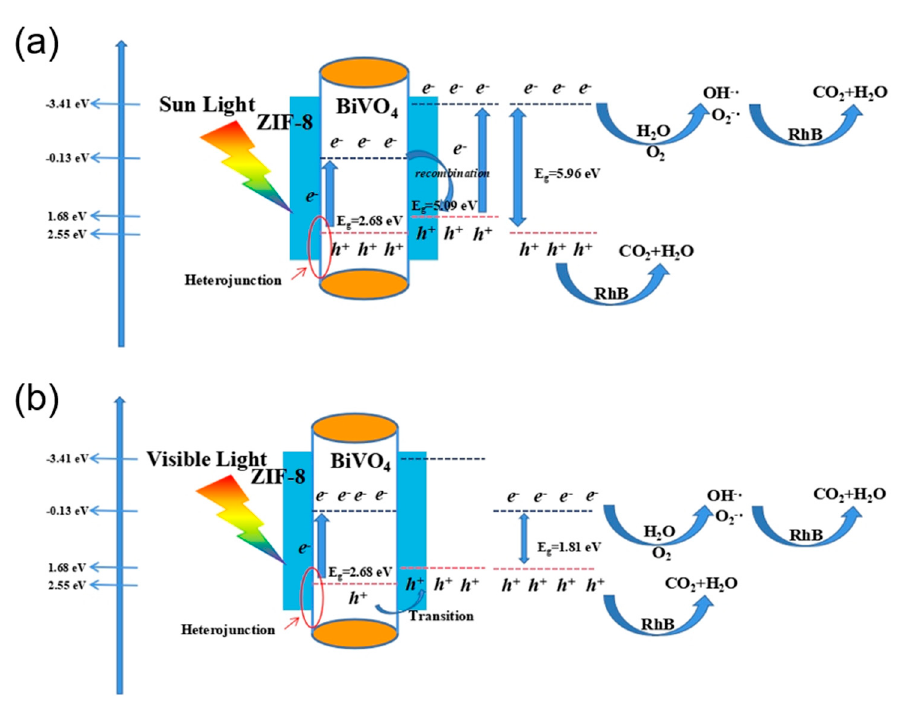
Figure 8. The working mechanism of RhB photodegradation under ( a ) sunlight and ( b ) visible